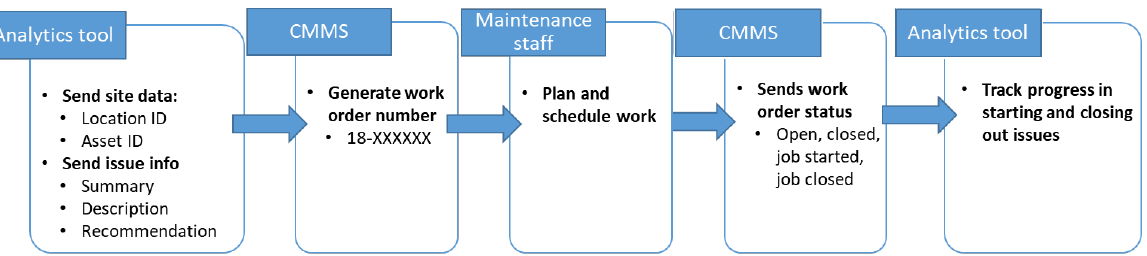
Figure 5. Integration of a building analytics tool and a CMMS (University of Iowa).